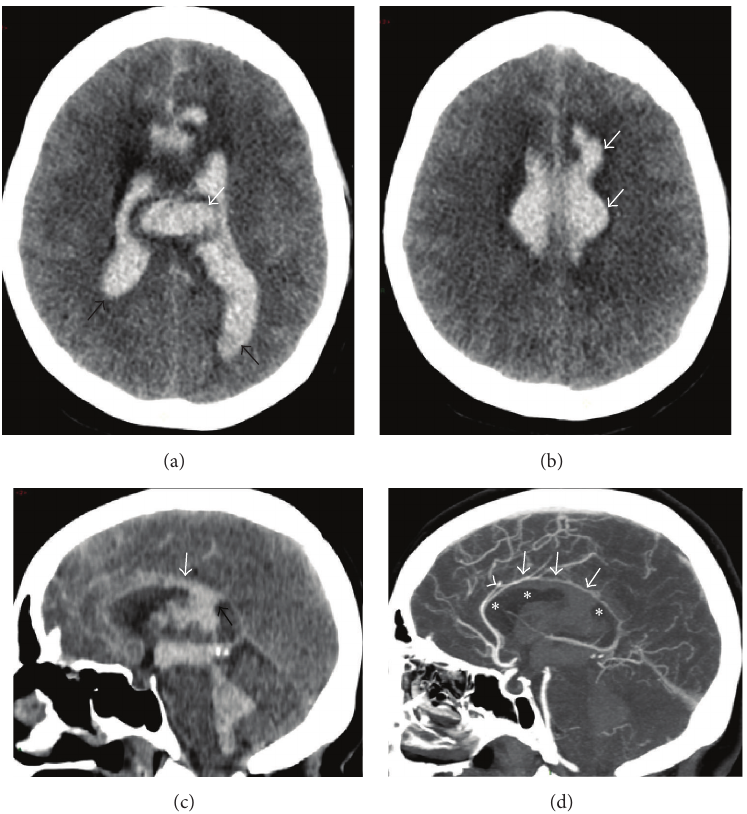
Figure 3: Admission CT scanner work-up of patient 2. (a) Unenhanced axial transverse view through the corpus callosum showing ovoid- shapedhematomawithinthemid-posteriorareaofthebodyofthecorpus(whitearrow),anteriorinterfrontalSAH,andmassivehaemorrhagic contamination of the whole ventricular system (black arrows). (b) Unenhanced axial transverse view tangent through the cranial aspect of the corpus callosum showing subpial fresh hematoma (arrows). (c) Unenhanced mid-sagittal reformatted view showing filling of the ventricular system by acute hyperintense blood, transgression of the posterior part of the body of the corpus callosum by fresh blood (black arrow), and subpial fresh hematoma at the upper border of the corpus callosum (white arrow). (d) Contrast-enhanced mid-sagittal reformatted view showing the causative RIA of the left ACA (arrowhead) and the subpial hematoma (arrows) on the cranial aspect of the corpus callosum (asterisks). Again, artifactual lowering of the apparent density of the hematoma because of changes in image scaling (window/level) after contrast agent injection (similarly as seen on Figure